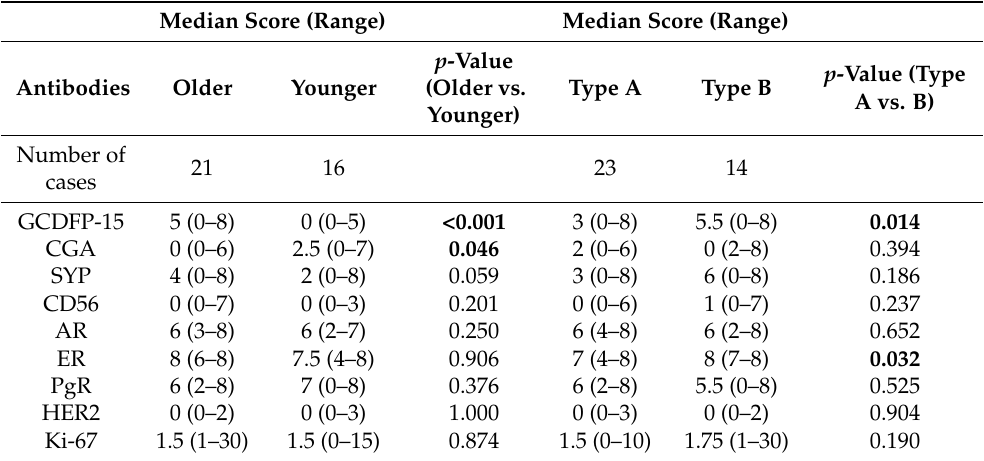
Figure 2. Immunohistochemical pictures of breast mucinous carcinoma. ( A ) SYP-positive cancer (older, type B), ( B ) CD56-positive cancer (older, type B), ( C ) AR-positive cancer (younger, type A), ( D ) AR-positive cancer (older, type B). AR, androgen receptor; SYP, synaptophysin. Scale bar = 50 μm. Table 3. Comparisons of immunohistochemical features of breast mucinous carcinoma by age group and type.